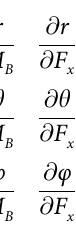
contact point space and mechanical variable space. For our mapping, the Jacobian with respect to the contact point is the 3 × 3 matrix shown in Eq 5. Each term is a partial derivative of a con- tact point coordinate with respect to a mechanical signal. The subscript “wobj” on contact point coordinates is dropped for brevity. , the radial distance along the whisker length. Similarly, the middle and bottom rows r wobj describe how small changes in mechanical variable measurements will affect θ the angles at which the whisker makes object contact. Thus, each column of the Jacobian shows how a single mechanical variable will affect the resultant contact point, and each row shows how all mechanical variables will individually affect a single contact point coordinate.